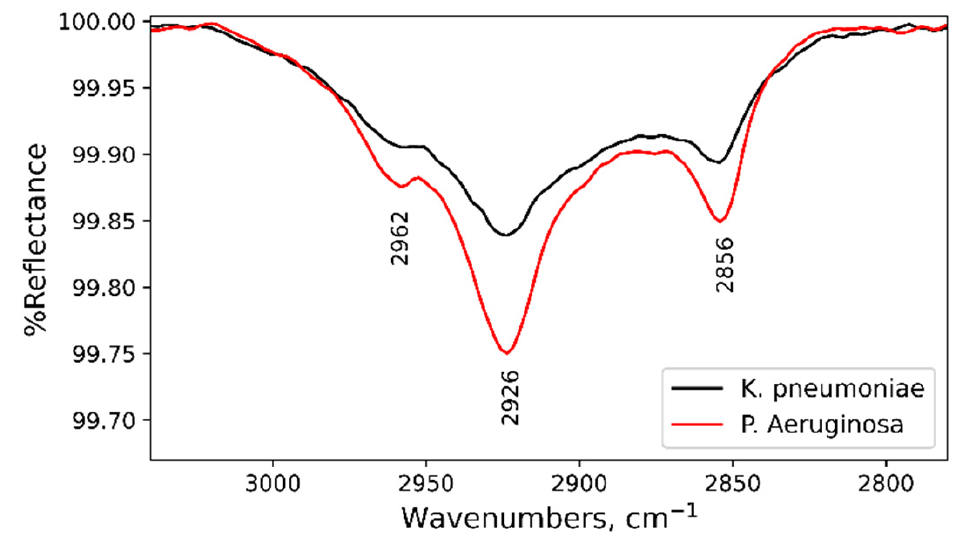
Figure 4. FT-IR reflectance spectra for the surfaces of superhydrophobic samples after 48 h of immersion in dispersions of K. pneumoniae and P. Aeruginosa . The reflectance bands at 2856 cm − 1 and 2926 cm − 1 correspond to symmetric and asymmetric C-H stretching vibrations in CH 2 groups, while band 2962 cm − 1 arises due to asymmetric C-H vibration in the CH 3 group [27] of bacterial cell membranes.